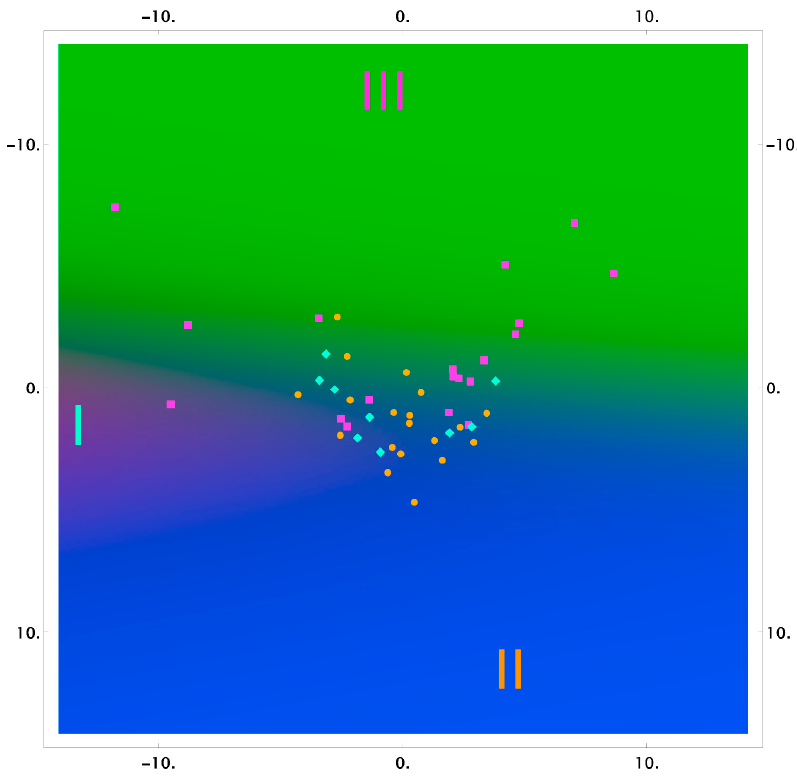
Figure 3. The 2D probability distribution of each class as a function of the features (enamel) of the studied groups I–III.